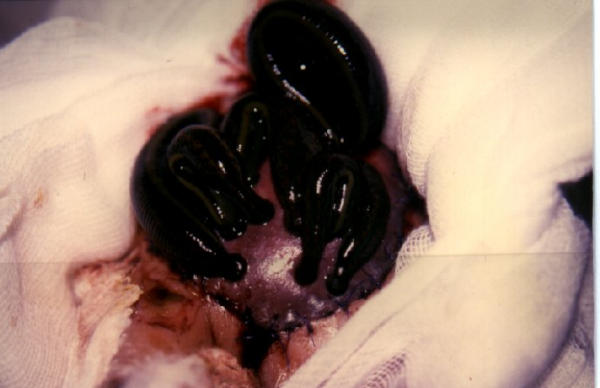
Leech usage in the treatment of venous insufficiency.